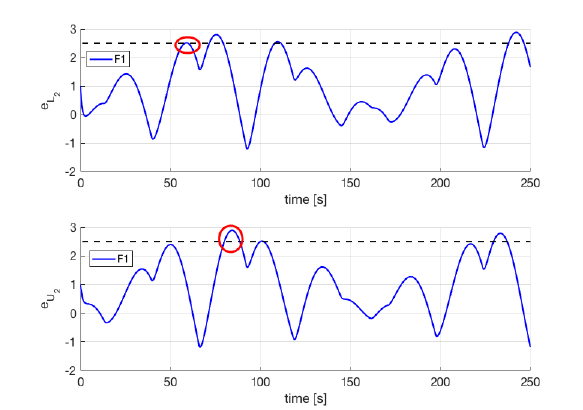
( t ) and e ( t ) . Once one of the two errors overcomes L 2 2